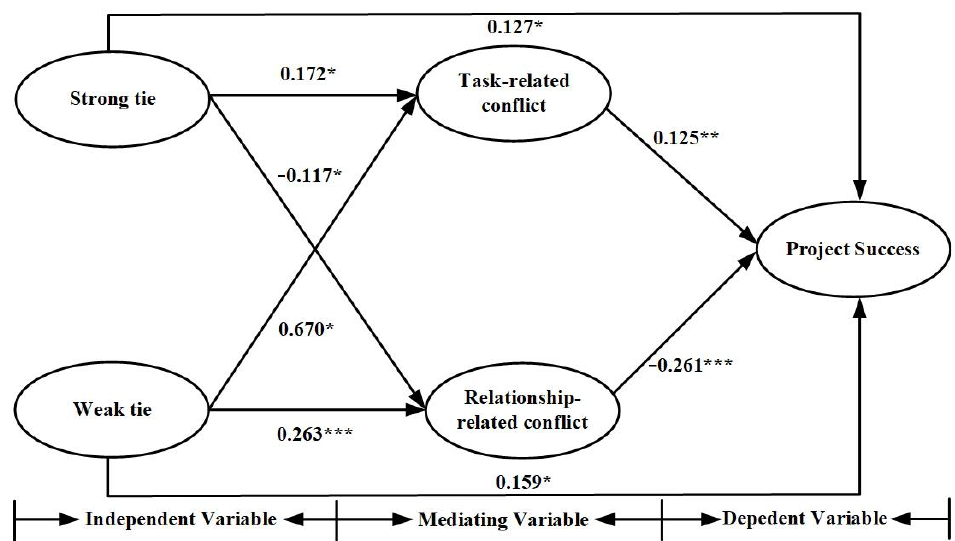
Figure 3. Results of theoretical model analysis. *, p < 0.05. **, p < 0.01. ***, p < 0.001. Table 5. Mediating effect